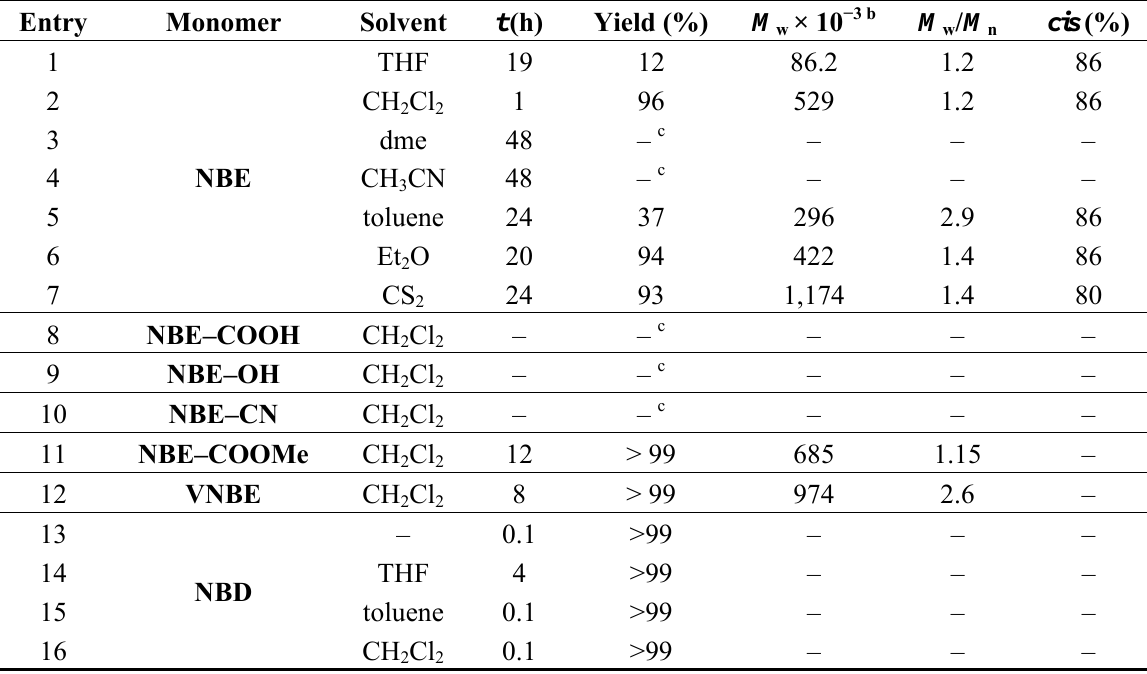
Table 1. Reactions of 1 with bicycloolefins a